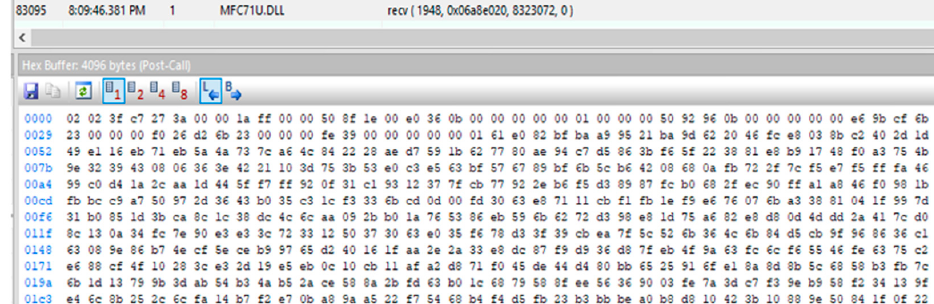
Figure A3. Process of receiving streaming data by connecting after sending all initial data.